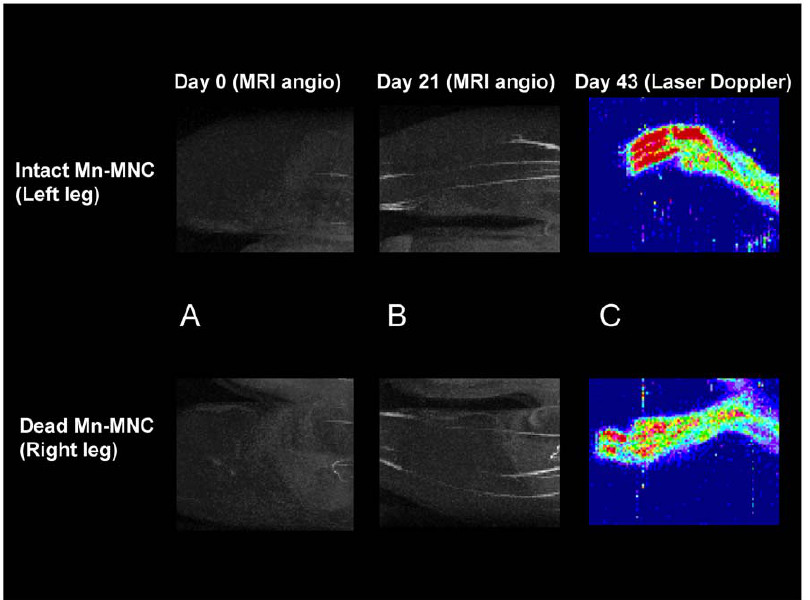
Figure 5. Chronic evaluation of angiogenesis using MRI angiography and Laser Doppler perfusion imaging. Representative MRI angiographs (A and B) and laser Doppler perfusion images (C) are presented. The MRI angiographic images were obtained at 0 (A) and 21 (B) days after muscle ischemia and MNC transplantation. Recovery of arterial blood flow was observed in the hindpaw for both the intact and dead MNC administered legs at 21 days. The intact MNC transplanted side showed a similar number of arteries to the contralateral side containing dead MNCs. The laser-Doppler perfusion image was acquired 43 days after the ischemia and transplantation (C). The muscle perfusion measured with laser- Doppler in the left legs (injected with intact MNCs) was 20 6 9% (n=6) higher than that in the right legs (dead MNCs).